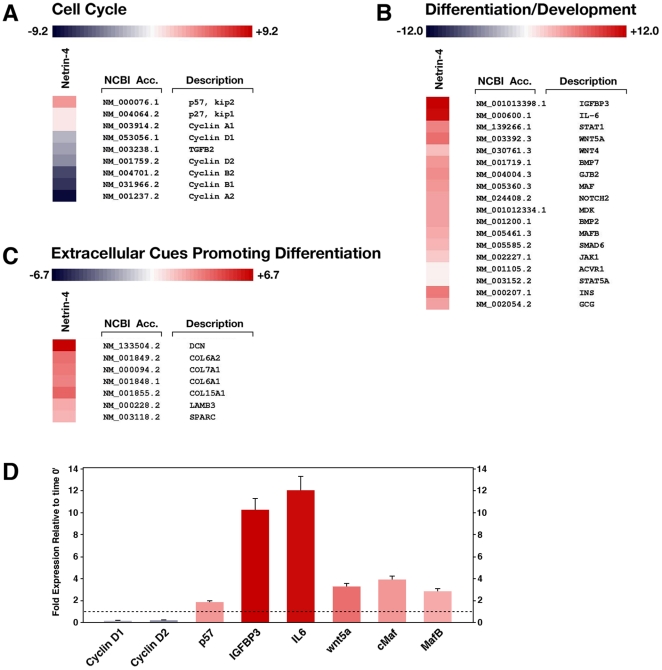
Pancreatic cell adhesion to Netrin-4 promotes cell cycle exit and fosters the expression of pro-differentiation genes.Heatmap of select genes that are either down-regulated (A) or up-regulated (B and C) by an 18-hours exposure of fetal pancreatic cells to Netrin-4. Data are presented as fold increase over time 0′. Note that known negative regulators of the cell cycle such as p57/kip2 and p27/kip1 are up-regulated (A), whereas positive regulators such as cyclins are down-regulated (A). Conversely, a number of genes whose function has been linked to events of cellular differentiation are all up-regulated (B, C). Changes in expression of select genes exemplified in panels A and B were validated by qPCR (D), where a value of 1 is equal to no change in gene expression. Complete array data have been deposited in the EBI Array Express Database (accession number pending). Data presented in D are representative of two independent experiments.